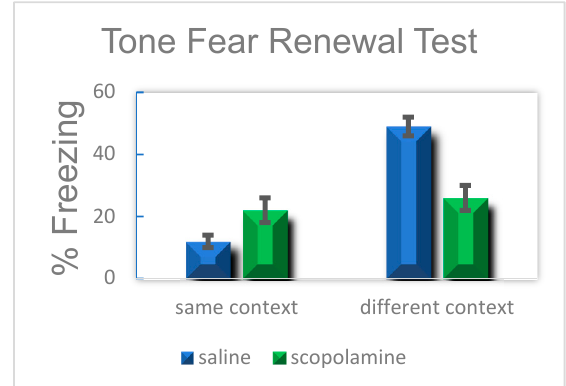
Figure 1. Mean percent freezing in animals assigned to either fear extinction (left) or different (right) context. Animals in the different context with systemically administered scopolamine did freeze at a percent that was significantly different from animals placed in the fear extinction context, indicating that they did not experience fear renewal (From Zelikowsky et al. 2012)